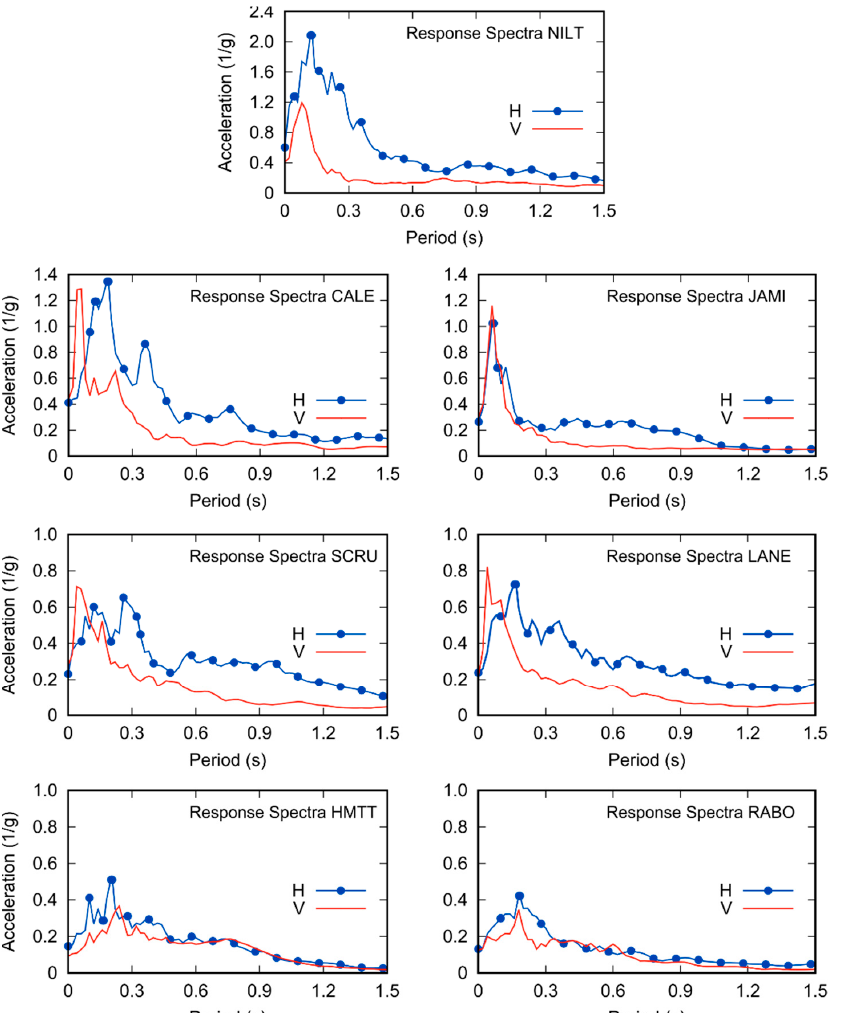
Figure 6. Response spectra used from different stations